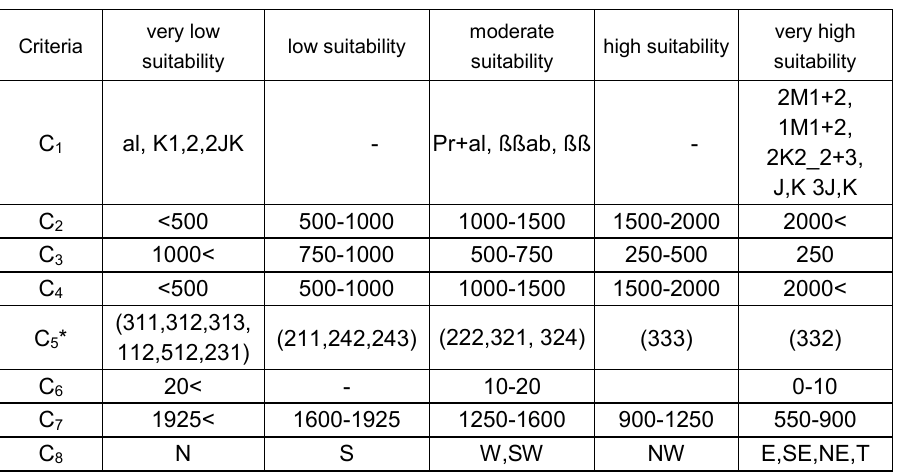
Table 3 – Criteria and limitations Таблица 3 – Критерии и удельные